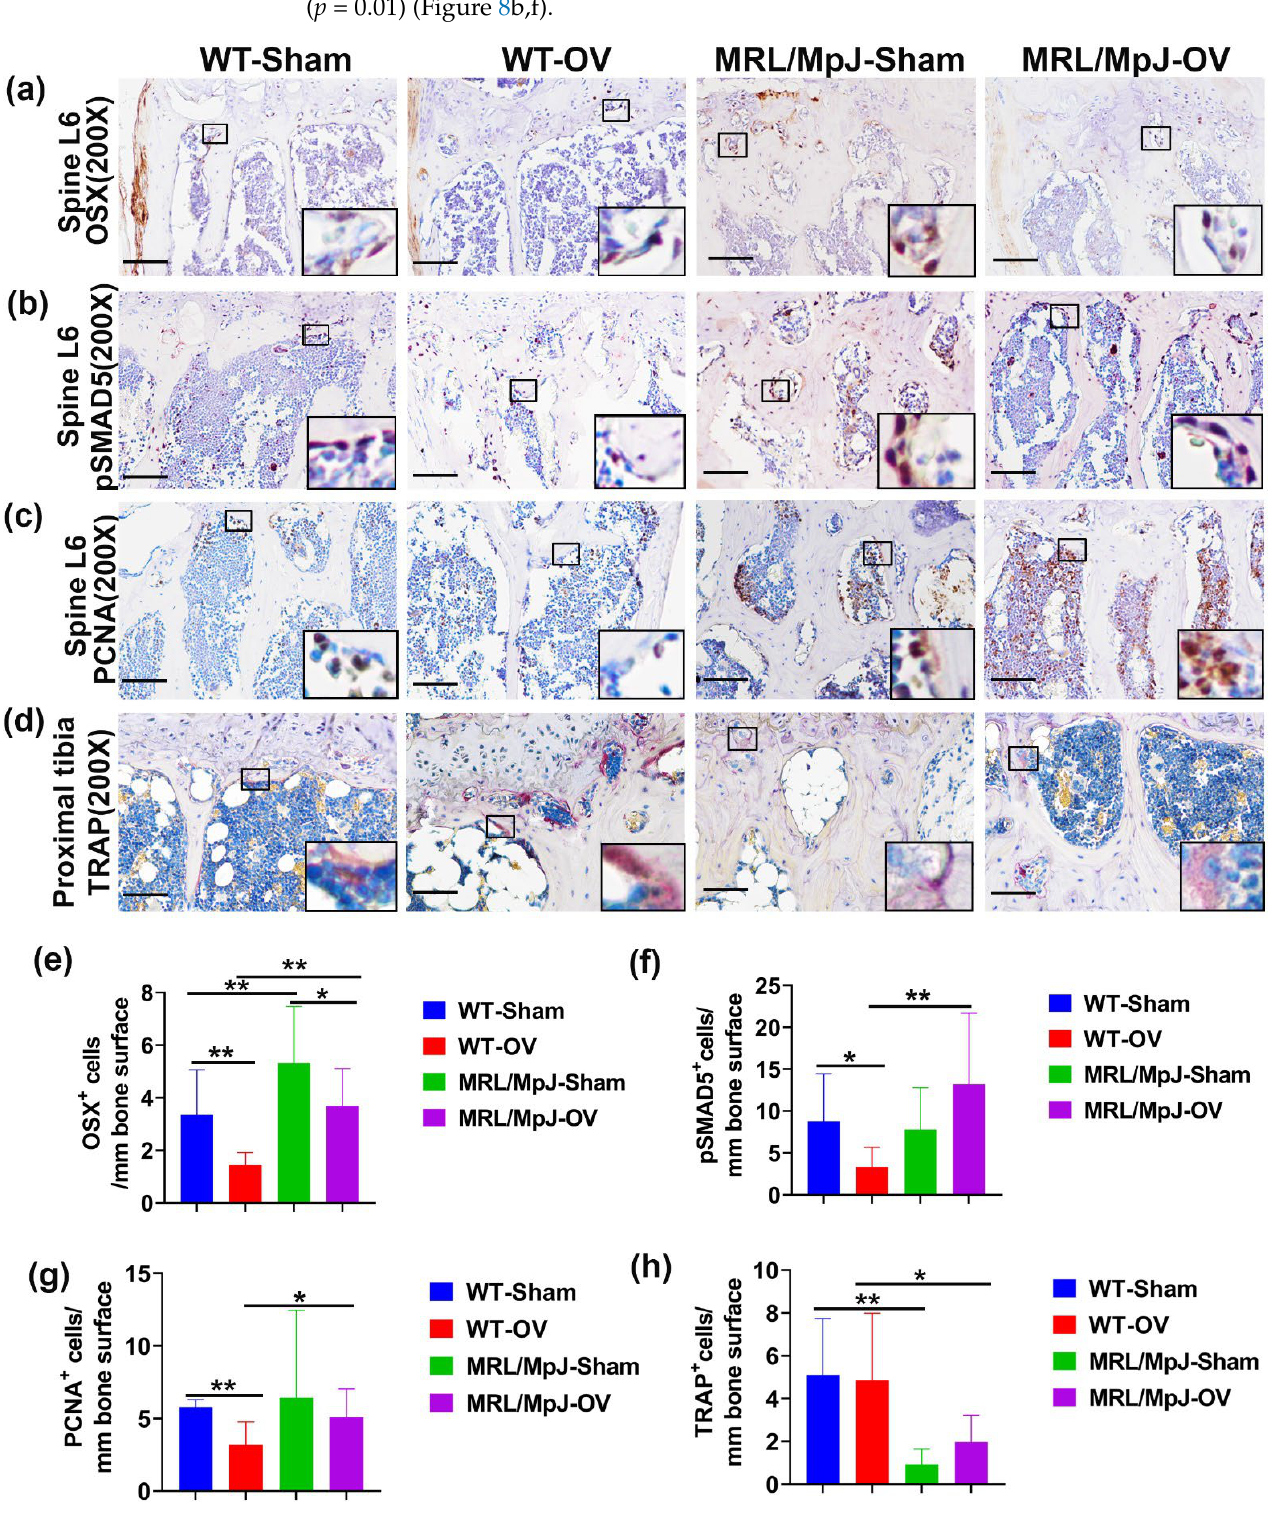
Figure 8. Immunohistochemistry and TRAP staining at 6 M after ovariectomy. ( a , e ) Immunohisto- chemical staining of OSX and quantification. OSX + cells are stained brown. Nuclei are stained blue. Insets highlight positive cells in each group. Scale bars = 100 µ m. The number of OSX + cells on the bone surface of WT-OV and MRL/MpJ-OV mice was significantly lower than the WT-Sham mice or MRL/MpJ-Sham mice. However, MRL/MpJ-OV and MRL/MpJ-Sham mice maintained significantly higher numbers of OSX + cells on the bone surface compared to WT-OV and WT-Sham, respectively.